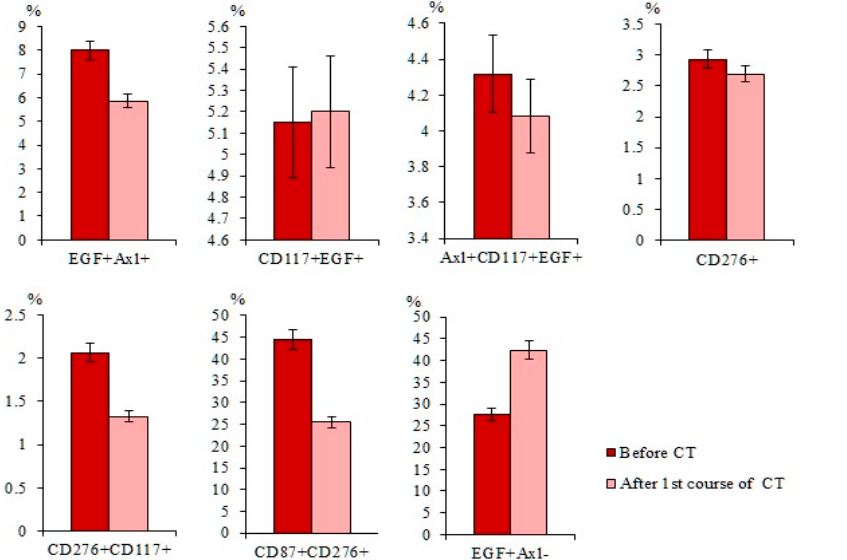
Figure 7. Content of CD87 + , CD87 + CD117 + , CD117 + Axl + EGF + CD44 + , EGF + Axl + , CD117 + EGF + , Axl + CD117 + EGF + , CD276 + , CD276 + CD117 + , CD87 + CD276 + , and EGF + Axl − circulating tumor cells (CTCs) in the blood of SCLC patients before and after first course of chemotherapy (CT) (% of all labelled mononuclear cells). Cells were analyzed by flow cytometry using antibodies for CD44, CD87, CD117, CD276, EGF, and Axl.